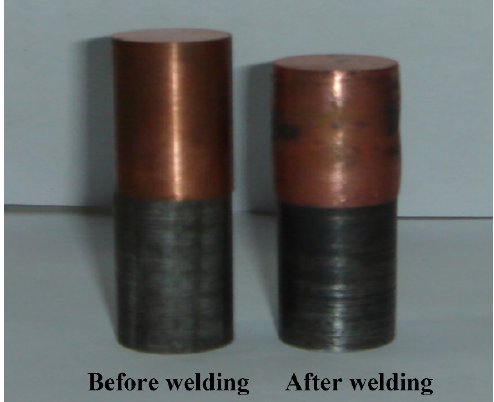
Figure 4. The welding deformation of the samples.